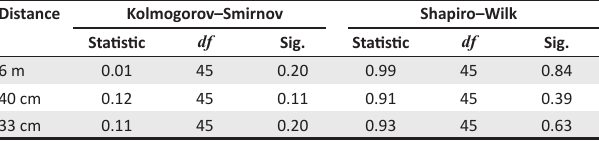
TABLE 1: Normality tests for the measurements of the amplitude of accommodation indicated that all three samples were normally distributed ( p > 0.05). Distance Kolmogorov–Smirnov Shapiro–Wilk